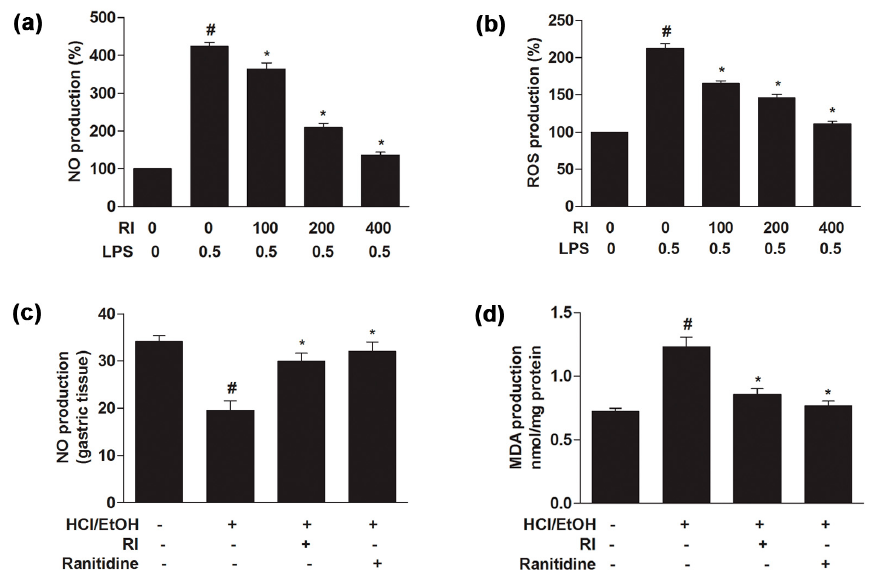
Figure 2. Protective role of RI on NO, intracellular ROS and MDA production in RAW 264.7 cells and gastric tissue. ( a ) NO; and ( b ) ROS production was measured by Griess and ROS-Glo H 2 O 2 assays in RAW 264.7 cells (upper panel). Cells were pretreated with various concentration of RI (100, 200, and 400 µg/mL) for 1 h, followed by co-treatment with RI and LPS (0.5 µg/mL) for another 24 h. ( c ) NO; and ( d ) MDA production in gastric tissue were measured by Griess and TBARS assays (lower panel). Mice were pretreated for 1 h with RI (400 mg/kg) and Ranitidine (40 mg/kg). After 1 h, HCl/EtOH (10 µL/g) was given orally. # p < 0.05 when compared with the control and * p < 0.05 when compared